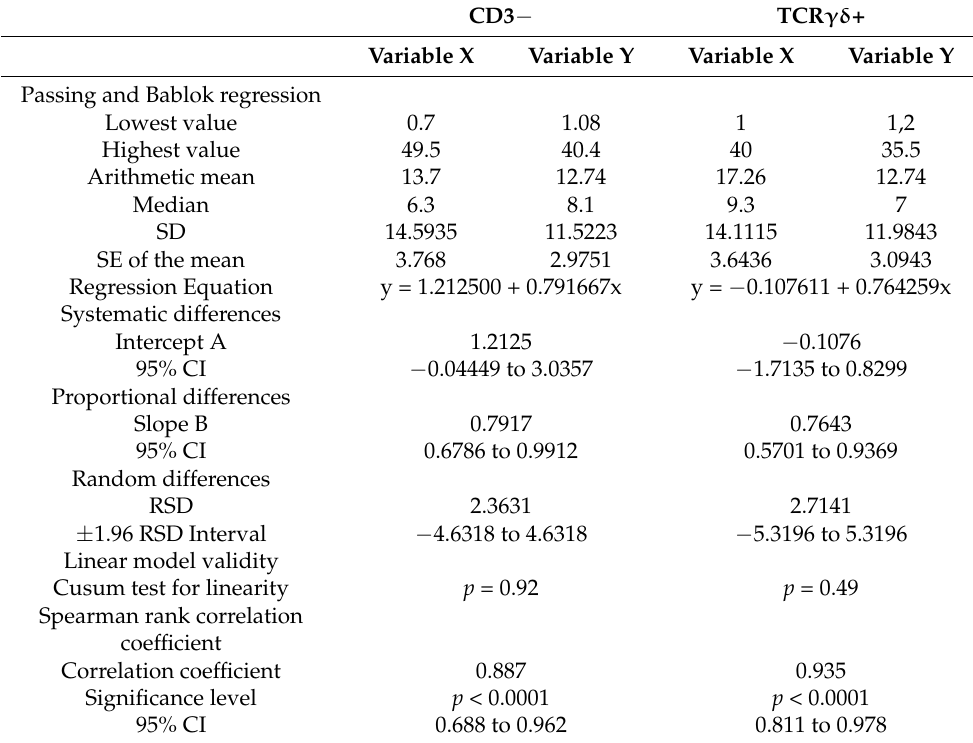
Table A4. Comparison of the different lymphocyte subpopulation data obtained in two different centres with the BD FACSCanto cytometer ( n = 15). Variable X shows data obtained in the reference centre (Hospital Ram ó n y Cajal) and variable Y shows data obtained in